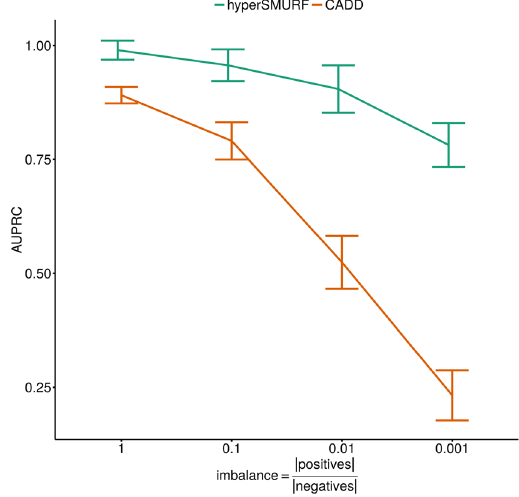
Figure 6. Performance at different imbalance levels. Area under the PR curve (AUPRC) results at different imbalance levels with imbalance-unaware (CADD) and imbalance-aware methods ( hyperSMURF ). The values on the X axis denote the ratio between positive and negative examples using Mendelian data. Error bars show, at each point, the cross-validated standard deviation.